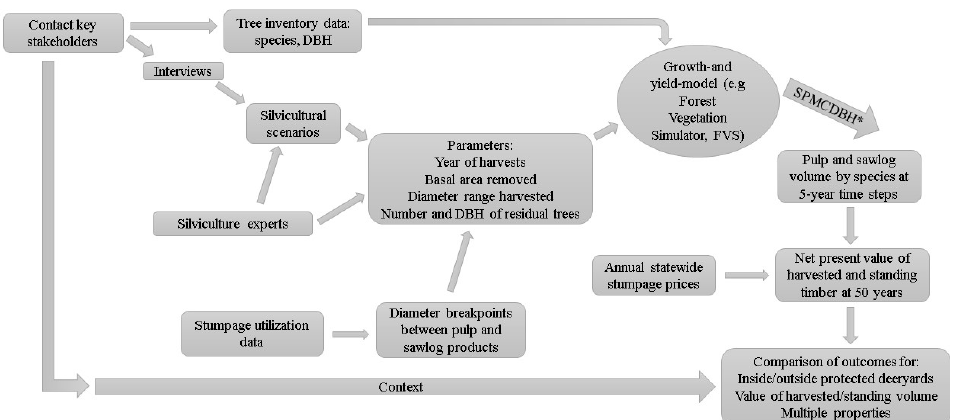
Figure 1. Conceptual model depicting the workflow from qualitative and quantitative input data through the output of the per-hectare value of timberland used in the comparison and interpretation of the impacts of a wildlife policy. SPMCDBH * is the FVS keyword that specifies the diameter cutoff of the impacts of a wildlife policy. * SPMCDBH is the FVS keyword that specifies the diameter cutoff between product between product classes.